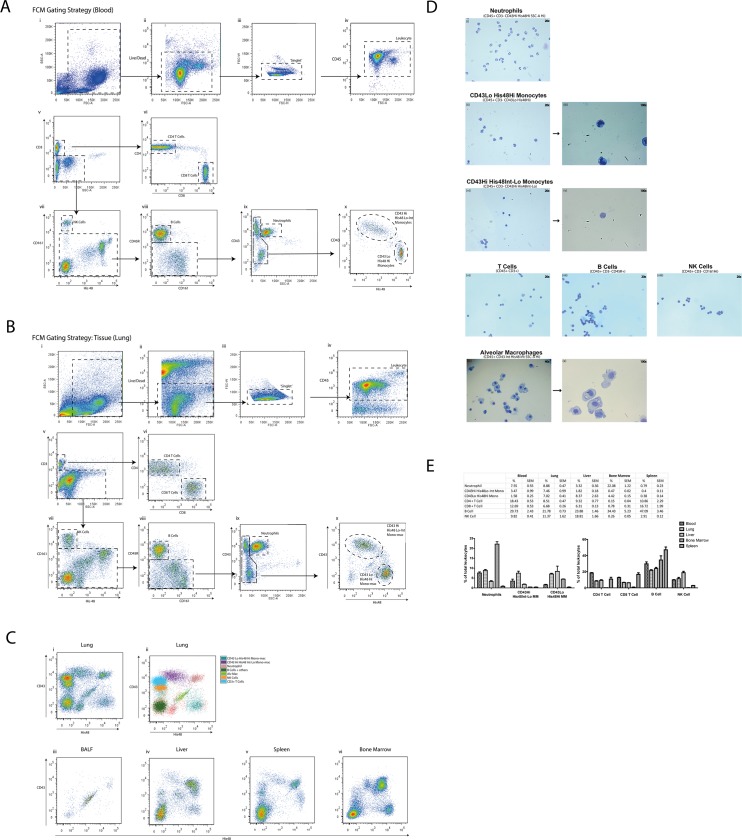
A 9-colour flow cytometric panel of major leukocyte subset discrimination in the rat.Rat blood (A) and lung tissue (B) were collected and processed for FCM staining with antibodies listed in Table 1. Cells from the lung were then back-gated to show cellular profiles according to specific antibody expression presented using CD43 and His48 expression, together with the corresponding distribution profiles for BALF, liver, spleen and bone marrow (C). Leukocytes from the blood and AlvMacs from the lung were then sorted and images of cytospins stained with wright-geimsa were obtained (D). Blood, lung, liver, spleen and bone marrow were processed, analysed and the relative proportion of each leukocyte population presented (E) where n = 3 naïve rats from a single experiment presented mean ± SEM.